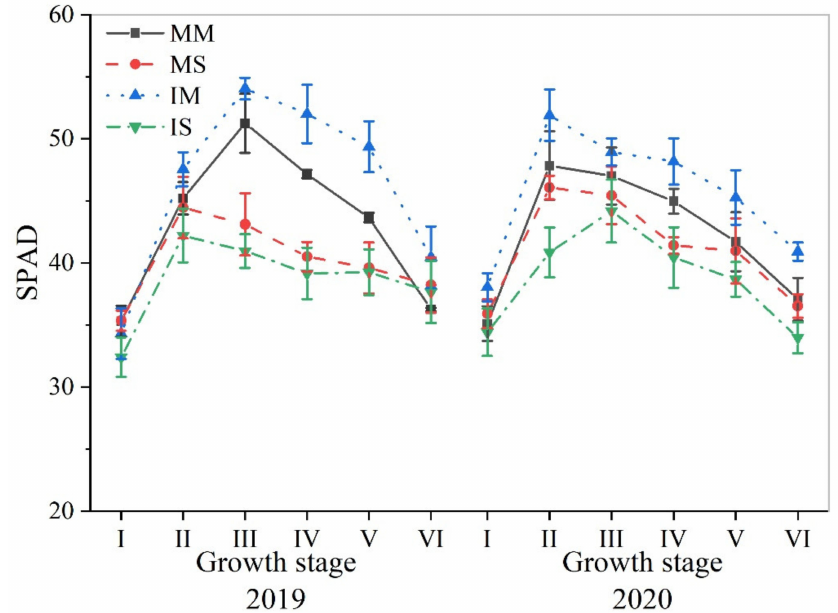
Figure 4. Dynamic changes in the SPAD values of maize and soybean in monoculture and under intercropping during 2019 and 2020. Abbreviations: MM—monocropping maize, MS—monocropping soybean, IM—intercropping maize, IS—intercropping soybean. In maize, I–VI mean seedling stage, jointing stage, large bell mouth stage, silking stage, grain filling stage, maturation stage, respectively. In soybean, I–VI mean seedling stage, branching stage, flowering stage, pod setting stage, drumming stage, maturation stage,